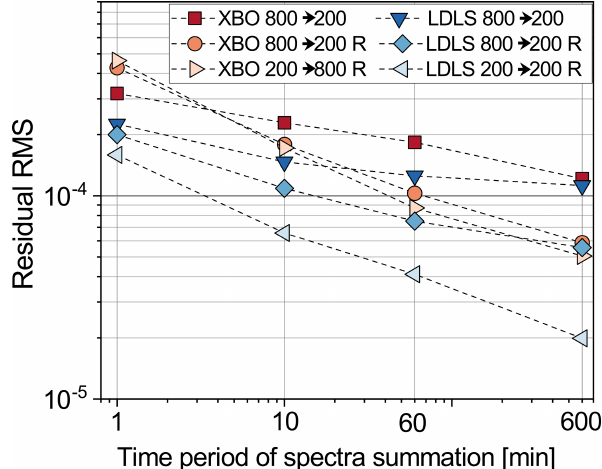
Figure 10. Systematic comparison of LP-DOAS setups with classi- cal fibre configuration, classical configuration with improved mode mixing, and the reversed fibre configuration with improved mode mixing for the benchmark light source XBO_75 and the LDLS. At- tained residual rms values for different summation periods up to 10h are